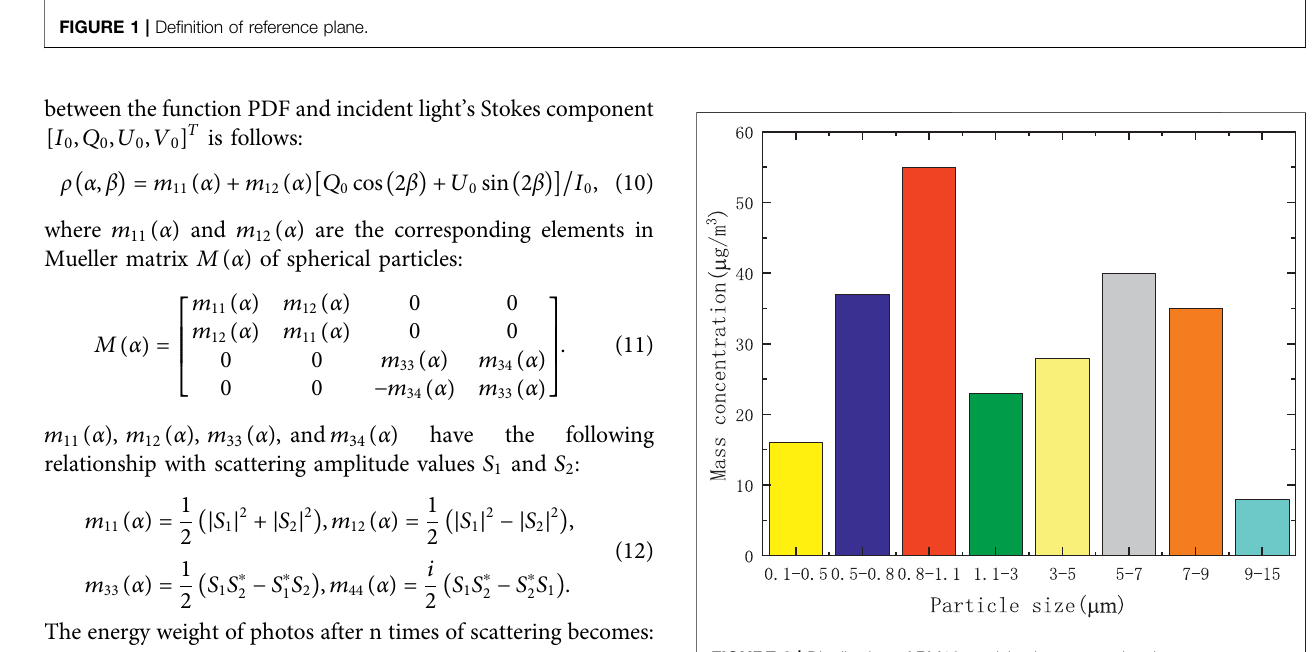
FIGURE 2 | Distribution of PM10 particle size content in